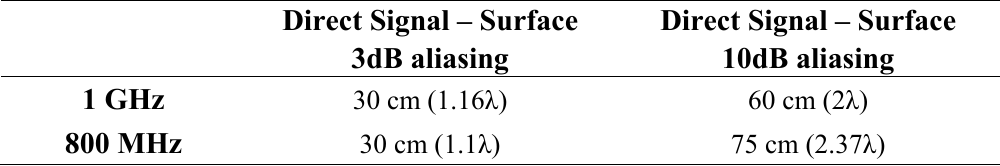
Table 4 . Minimum distance between antenna and surface to obtain a reflected wavelet at different overlapping degrees. Measurements were obtained with high stacking (512) to ensure adequate signal